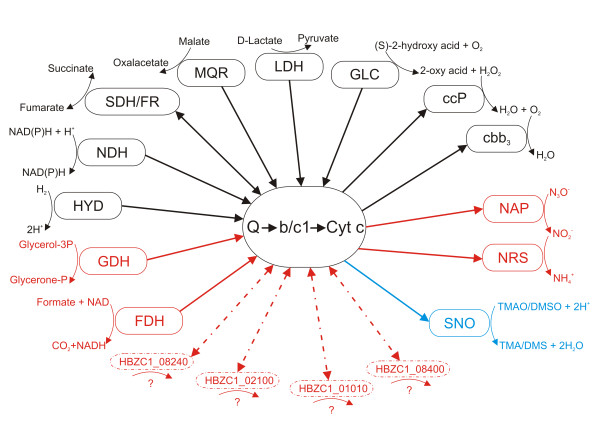
Schematic representation of the respiratory pathway in Helicobacter bizzozeronii CIII-1. In red the reactions predicted to be present in H. bizzozeronii CIII-1 but not in H. pylori. In black the reactions predicted to be in common in both Helicobacter species. In blue TMAO/DMSO reduction which could be predicted also in H. pylori but a complete set of enzyme is not present. The arrows indicate the direction of the electrons to or from the membrane-bound electron transport chain. Dashed lines indicate that the direction of the electrons is unknown. Enzymes catalyzing key reactions are indicated in boxes. FDH, formate dehydrogenase; HYD, hydrogenase; NRS, nitrite reductase system; SNO, S- and N- oxidases; GDH, glycerol-3-phosphate dehydrogenase; NDH, NAD(P)H dehydrogenase; SDH/FR, succinate dehydrogenase/fumarate reductase; MQR, malate-quinone-reductase; LDH, lactate dehydrogenase; GLC, glycol oxidase; NAP, periplasmic nitrate reductase; Q, quinone; Cyt b/c1, quinone cytochrome oxidoreductase; Cyt c, cytochrome c; cbb3, cytochrome c oxidase; ccP, cytochrome c peroxidase.